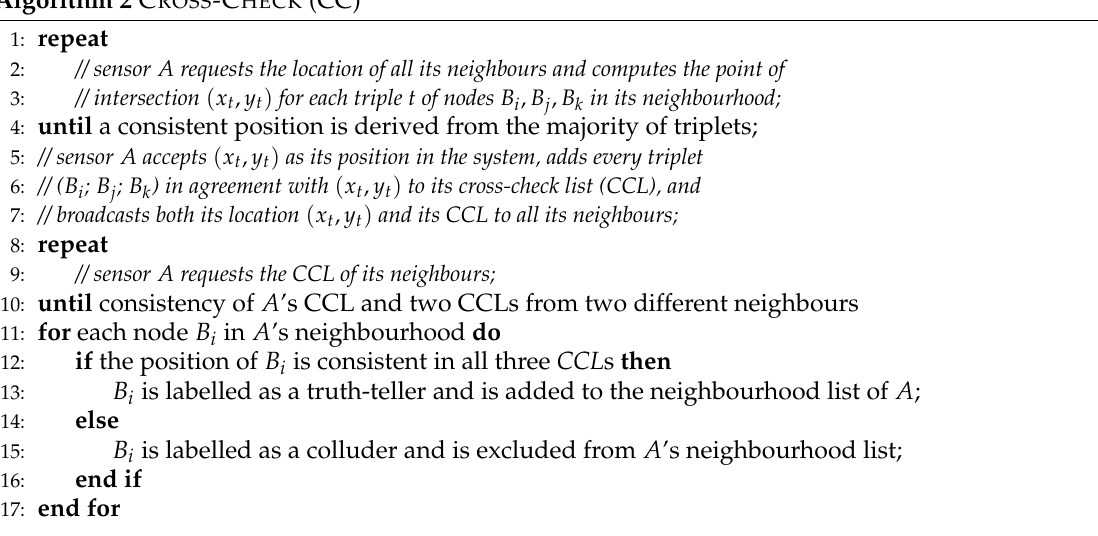
Algorithm 2 C ROSS -C HECK